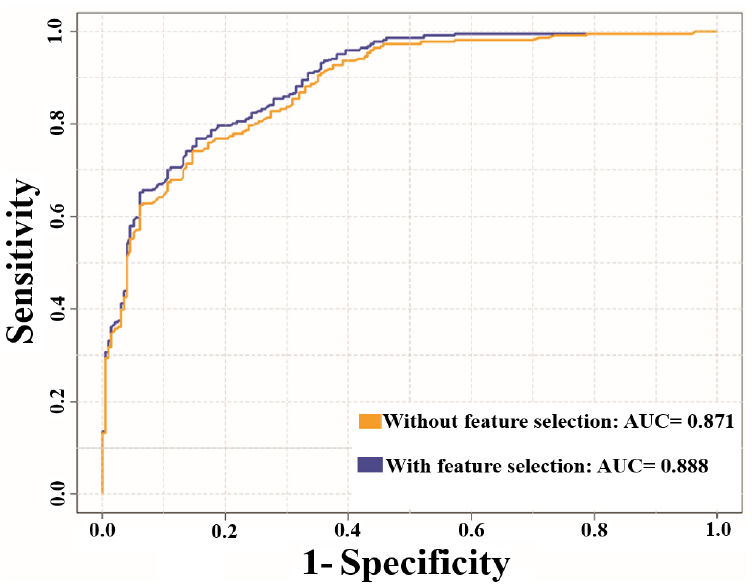
Figure 5. AUC values after sequence redundancy removal. Blue and orange color represents without and with feature selection.